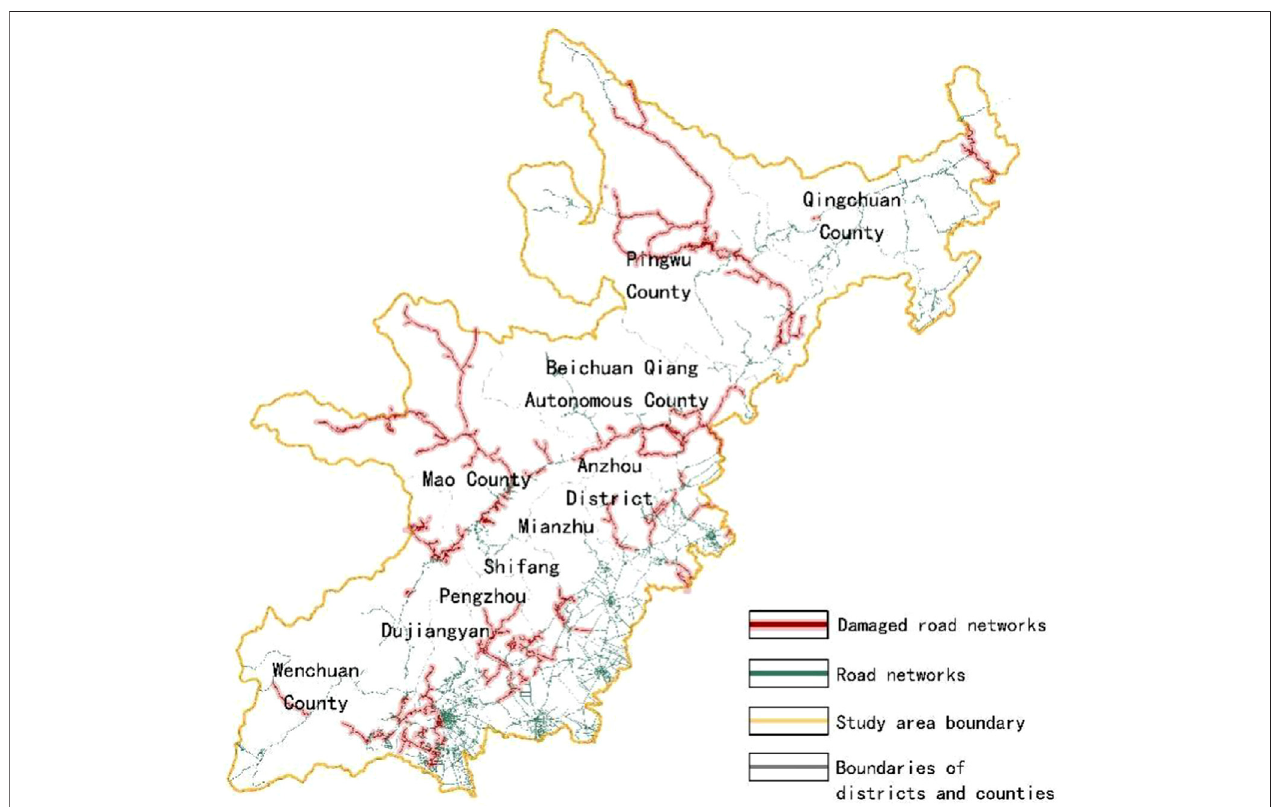
FIGURE 5 | Schematic representation of the damaged road network when repaired during the golden